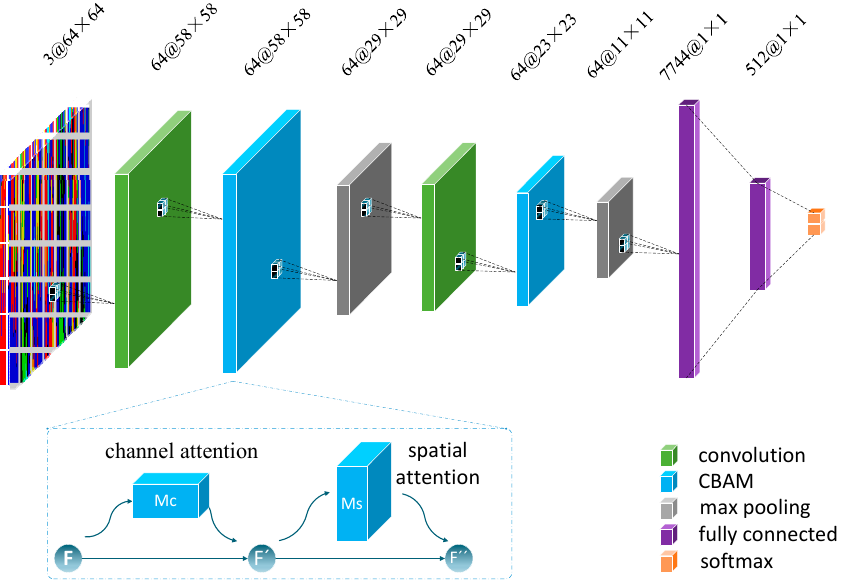
Figure 5. Proposed CNN structure with the CBAM module; the CBAM module is also described. In IS-CBAM-CNN, the CBAM is embedded in the middle of the convolutional and pooling layers. The CBAM module includes two parts. The first part is the channel attention map M C ∈ R C × 1 × 1 , which enables the selection of channels. The other part is the spatial attention map M S ∈ R 1 × H × W , which selects the areas of the image space that require attention. C, H, and W are the indicators of the number of channels, height, and width of the feature map, respectively. As shown in Figure 5, the feature map output F ∈ R C × H × W from the convolution layer passes through a channel attention module. The output F (cid:48) is weighted and fed into a spatial attention module. The final weighting F (cid:48)(cid:48) is done to get the result to be passed to the pooling layer. The overall attention process can be summarized as shown in Equations (4) and